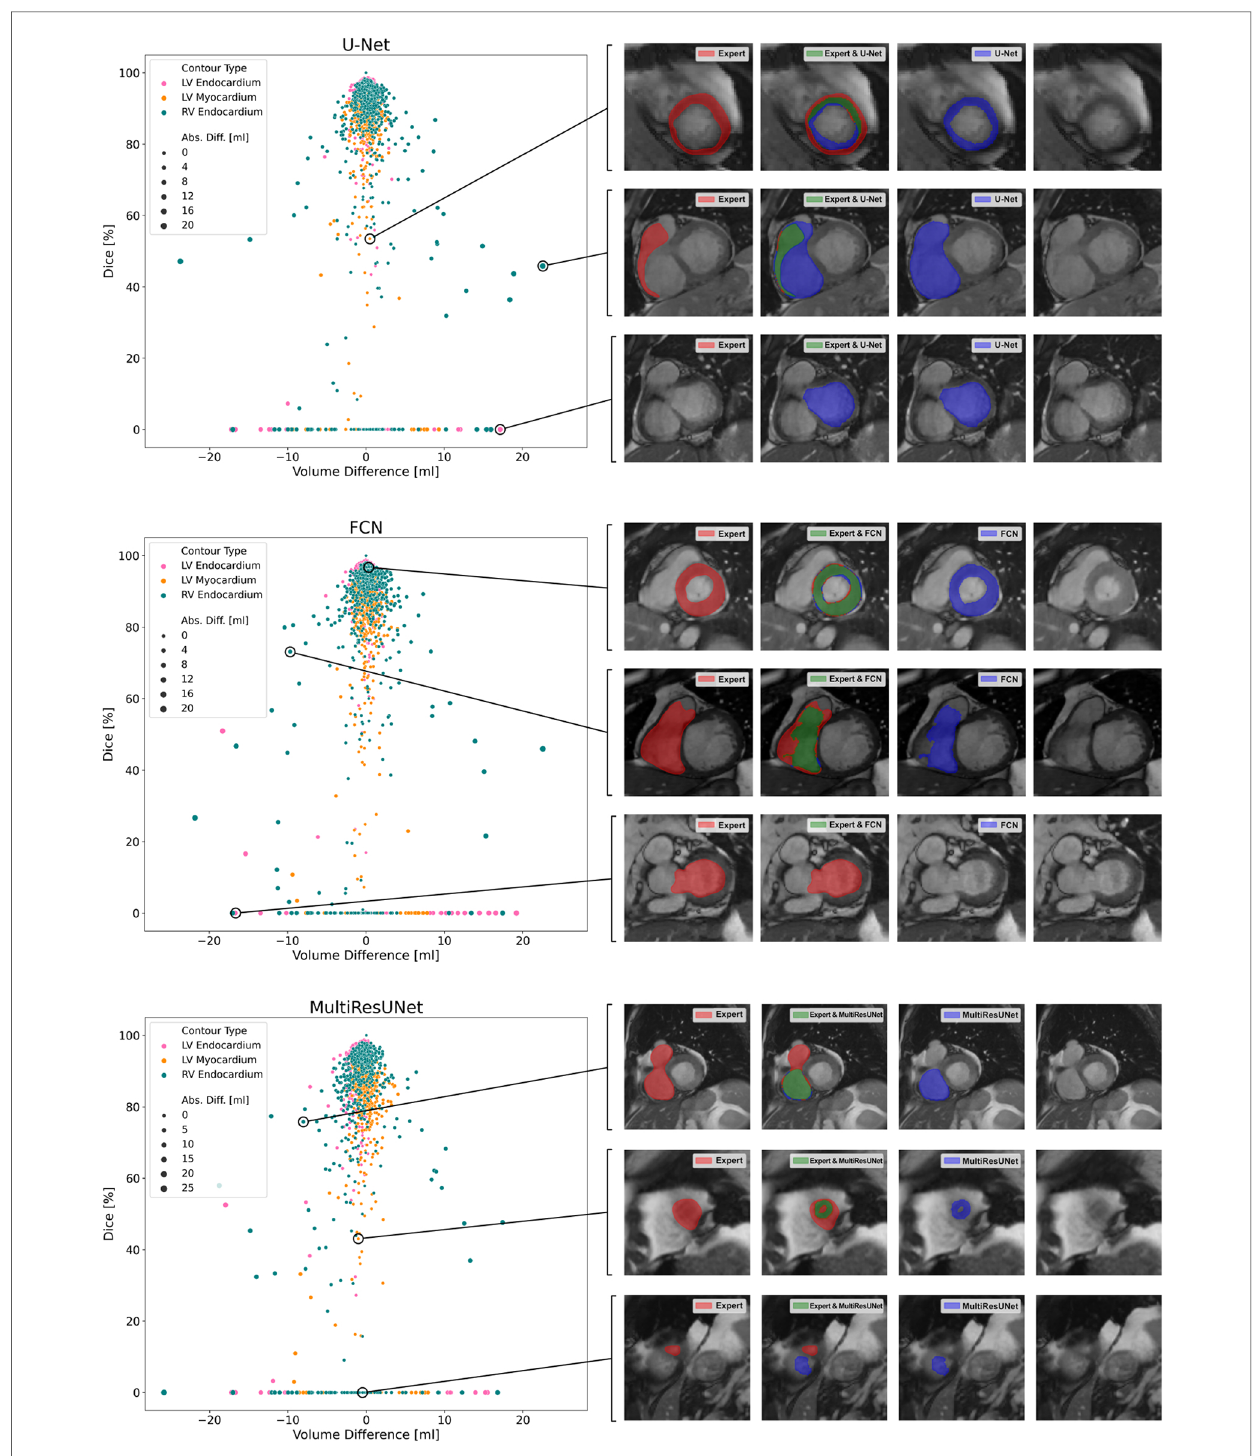
FIGURE 5 Correlation plots of segmentation comparisons. Each subplot shows the comparison of the contours of a neural network to the expert. Points represent contour comparisons and are distributed based on volume difference in milliliters and Dice. For interactive qualitative error analysis, visualizations of segmentation agreement could be displayed when clicking on a point. Examples are given on the right side of the fi